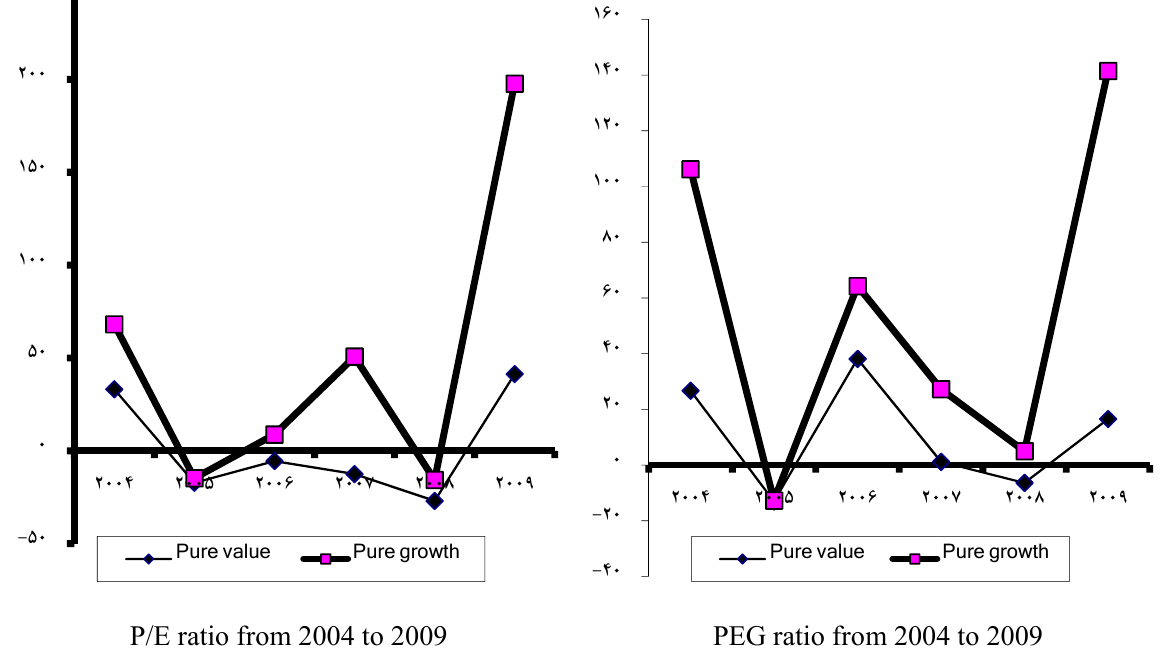
Fig. 1. Variation in returns of pure value stock and pure growth